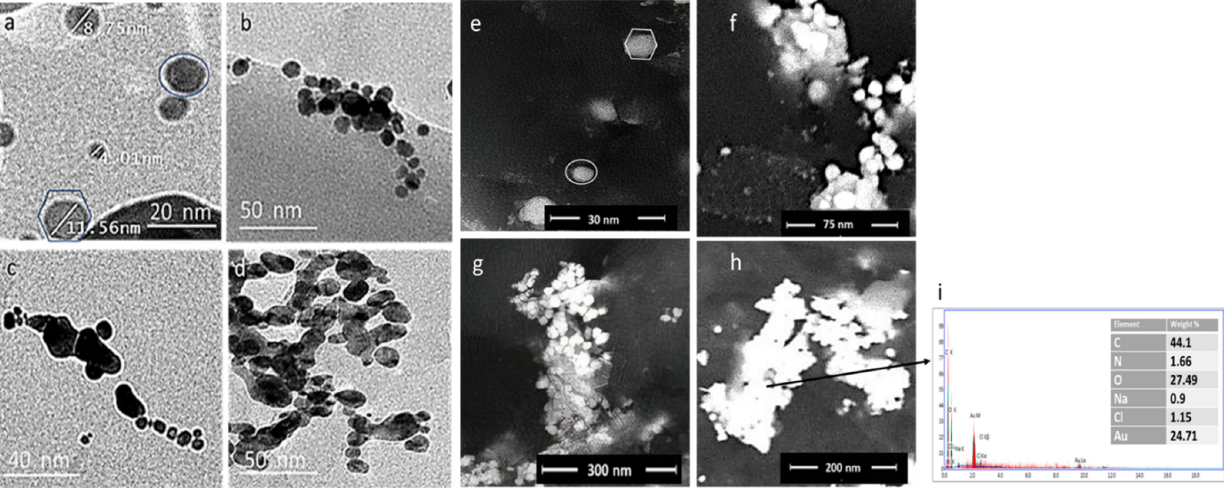
Figure 4. TEM micrographs for ( a ) prepared GNPs ( b ) GNP-kaempferol ( c ) GNP-chrysin, and ( d ) GNP-quercetin and FESEM micrographs for ( e ) prepared GNPs, ( f ) GNP-kaempferol, ( j ) GNP-chrysin, and ( h ) GNP-quercetin. ( i ) Elemental analysis by energy dispersive X-ray (EDX) analysis for GNP-quercetin.